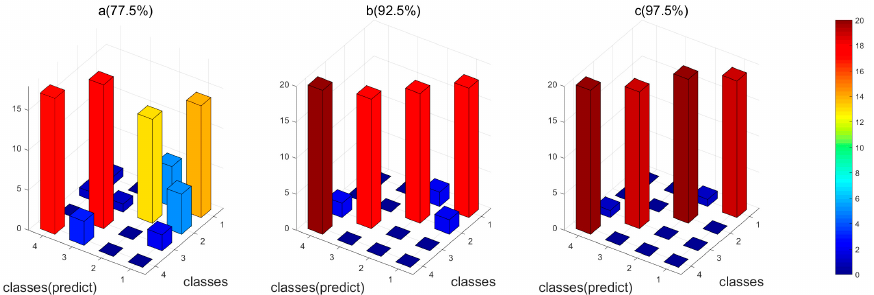
Figure 6. The 3D plot of classification results of the four feature fusion methods for Dataset I. ( a ) The conventional feature fusion method without feature selection; ( b ) The proposed feature fusion method without feature selection; ( c ) The proposed feature fusion method with feature selection; (Note: 1, No infection; 2, S. aureus ; 3, E. coli ; 4, P. aeruginosa .).